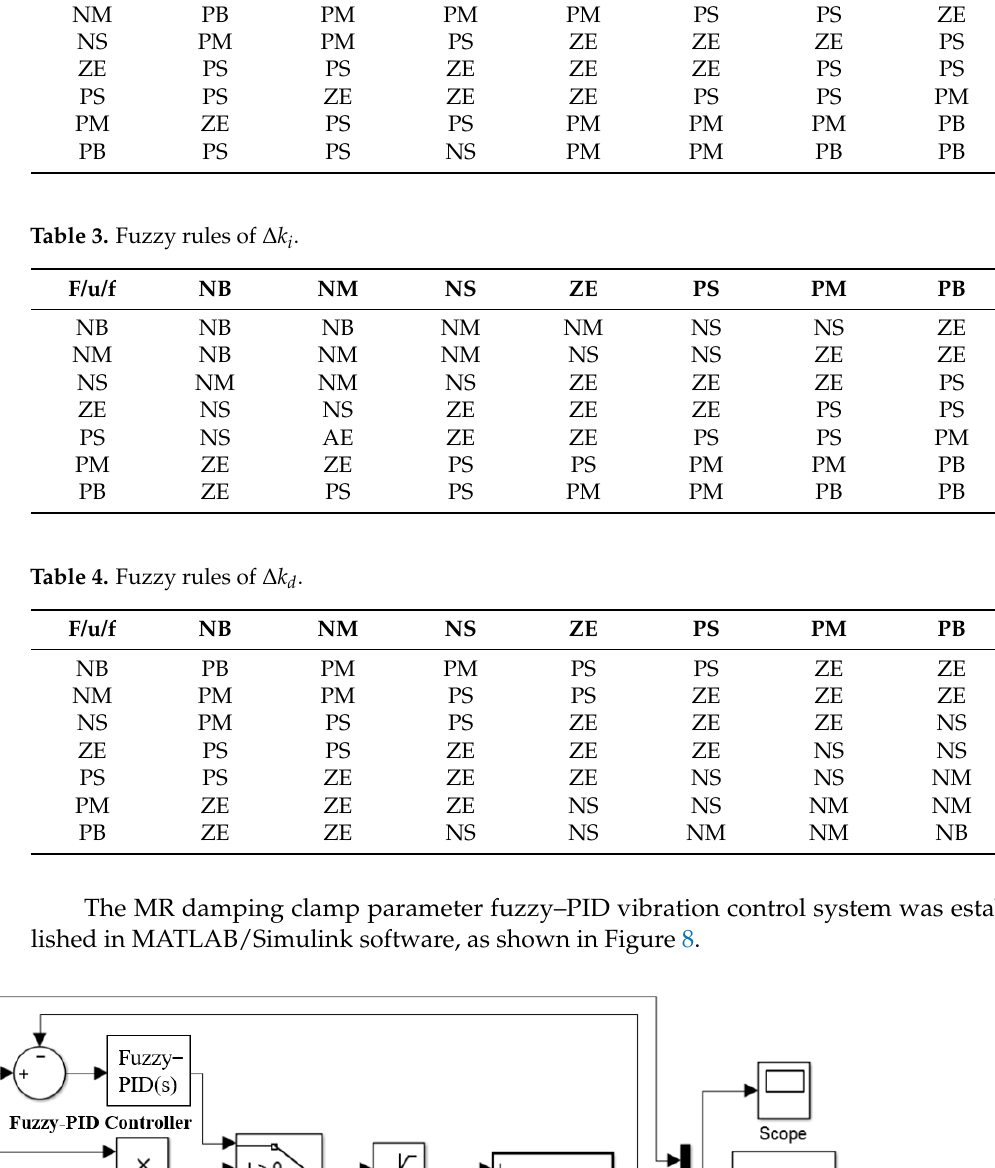
Table 4. Fuzzy rules of ∆ k d .